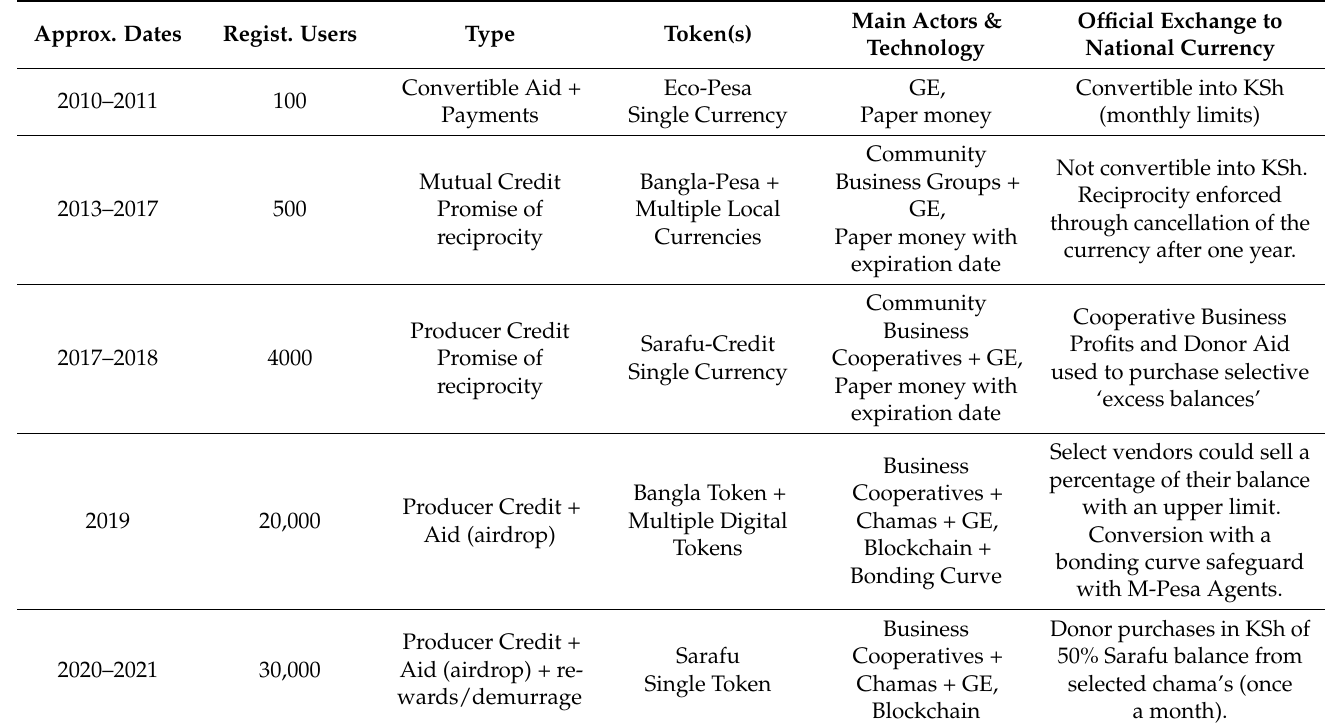
Figure 1. Sarafu Paper Currency, 2017. This particular currency note was renewed by a Bangla-Pesa community stamp. Expiration was a way to cancel excess positive balances and incentivize reciprocity. Table 1. Overall Timeline and Brief Evolution of GE CCs and